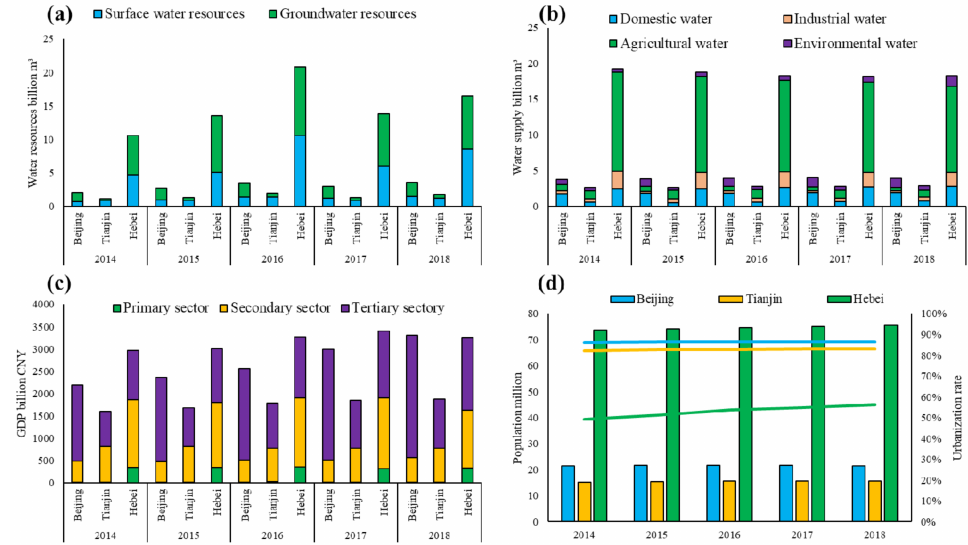
Figure 6. The water resources and socio-economic characteristics of Jing-Jin-Ji Region: ( a ) water resources; ( b ) water supply; ( c ) GDP; ( d ) population.